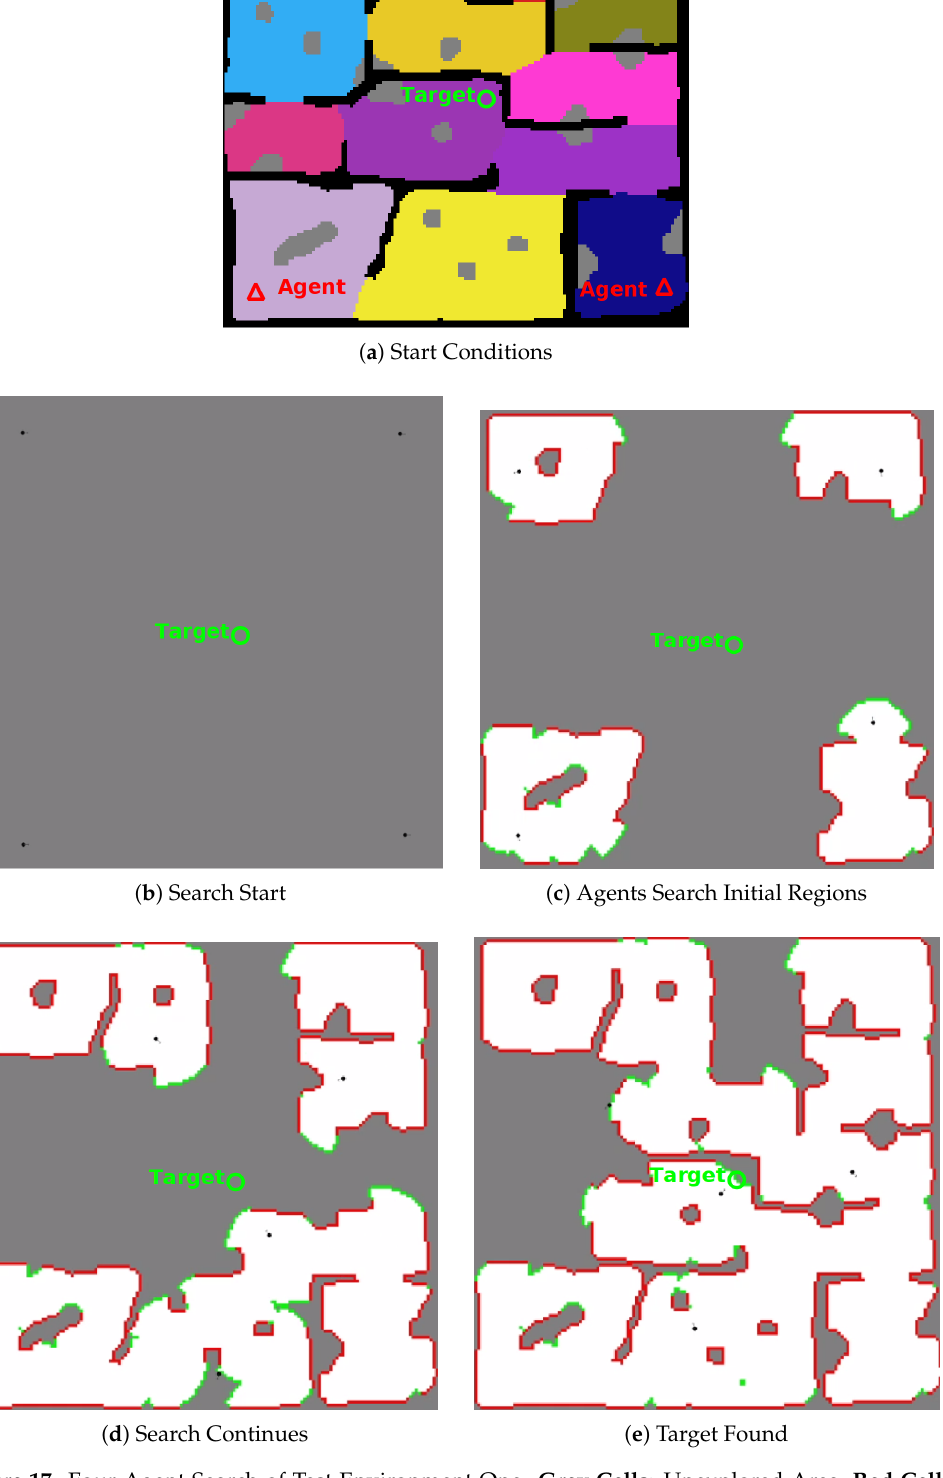
Figure 17. Four Agent Search of Test Environment One. Grey Cells : Unexplored Area, Red Cells : Observed Obstacle Cells, Green Cells : Safe Edges of Unexplored Region, White Dotted Circle : Target